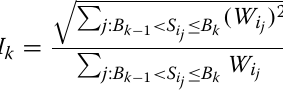
, Y 1 ) , Y 2 ) , Y population is then the scatterplot of the pairs ( X 1 , ( X 2 , ..., ( X ℓ ℓ ) in black and , Y 1 ) , ( Y 2 ) , ..., ( Y ℓ ) in gray. Comparing the black plotted points (pos- X 2 , X ℓ , the pairs ( ˜ X 1 ˜ ˜ ˜ ˜ ˜ sibly connected with black lines) to the gray plotted points (possibly connected with gray lines) gives an indication of deviation of the subpopulation from the full population. Two 1 (similar choices pertain natural choices of the bins whose endpoints are B 1 , B 2 , ..., B ℓ − 1 ) include {1} have B 1 , B 2 , ..., B ℓ 1 be equis- to the bins whose endpoints are ˜ B 1 , ˜ B 2 , ..., ˜ B ℓ − − 1 such that paced, and {2} choose B 1 , B 2 , ..., B ℓ − ( W i ) 2 j (cid:31)(cid:30) j : B k 1 < S ij ≤ B k − (38) U k W i = j (cid:30) j : B k − 1 < S ij ≤ B k